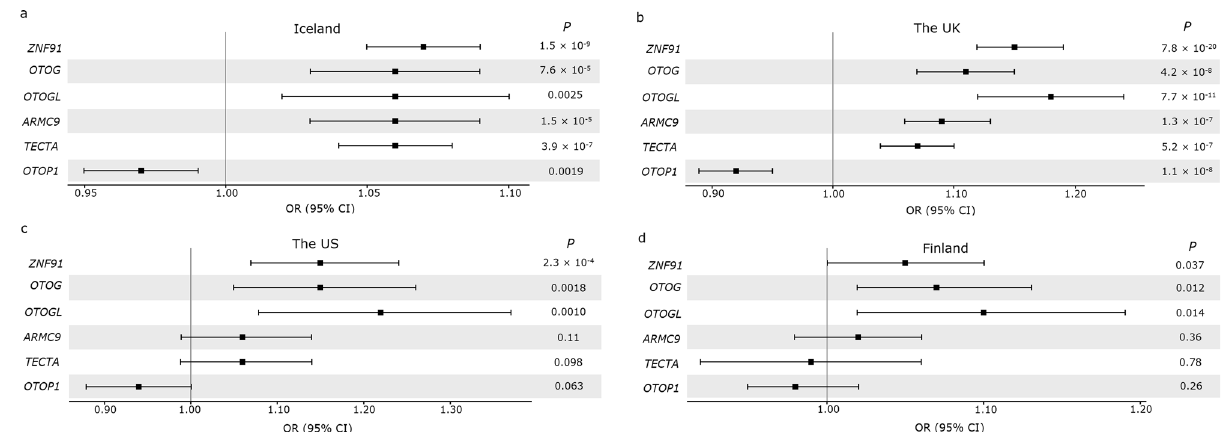
Fig. 3 Risk comparison of the six lead sequence variants uncovered in the meta-analysis in the four datasets. A forest plot comparing the risk of the sequence variants (represented by the gene for simpli fi cation) associating with vertigo in the meta-analysis (Supplementary Data 1), in a Iceland (30,802 cases and 278,502 controls), b the UK (9715 cases and 421,332 controls), c the US (1888 cases and 24,961 controls), and d Finland (5667 cases and 169,746 controls). The error bars indicate